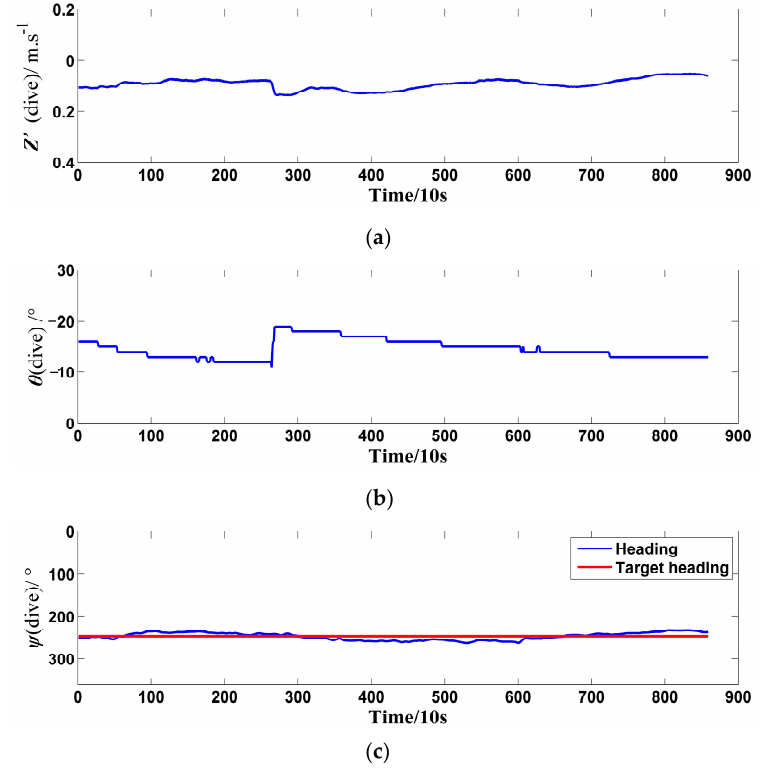
Figure 14. Datasets of Petrel-L in dive motion: ( a ) vertical velocity, ( b ) pitch angle, ( c ) heading.